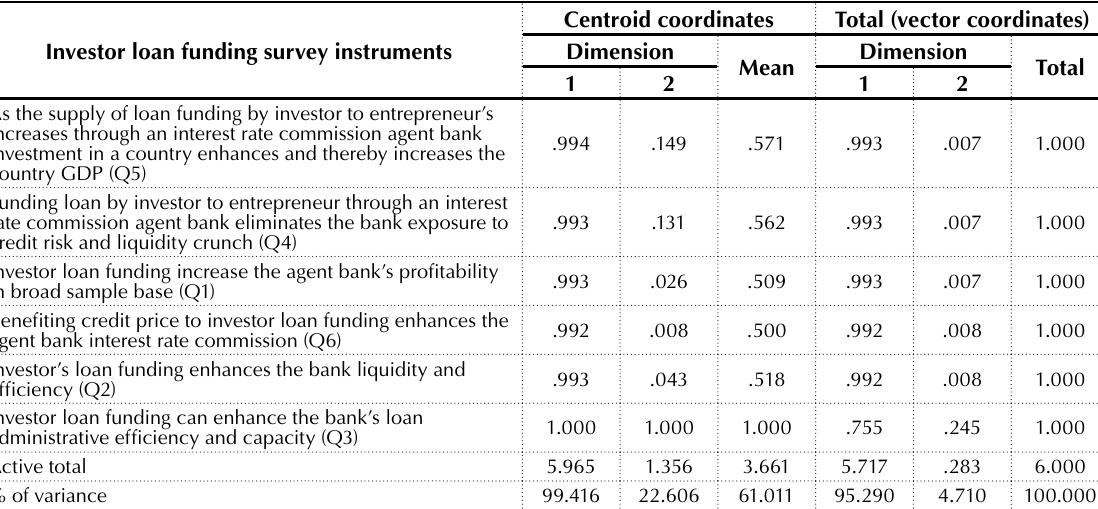
Table 14. Variance accounted